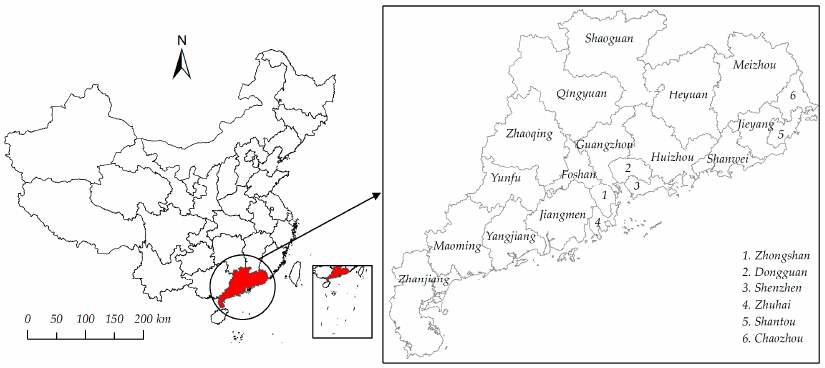
Figure 1. Location of Guangdong province.